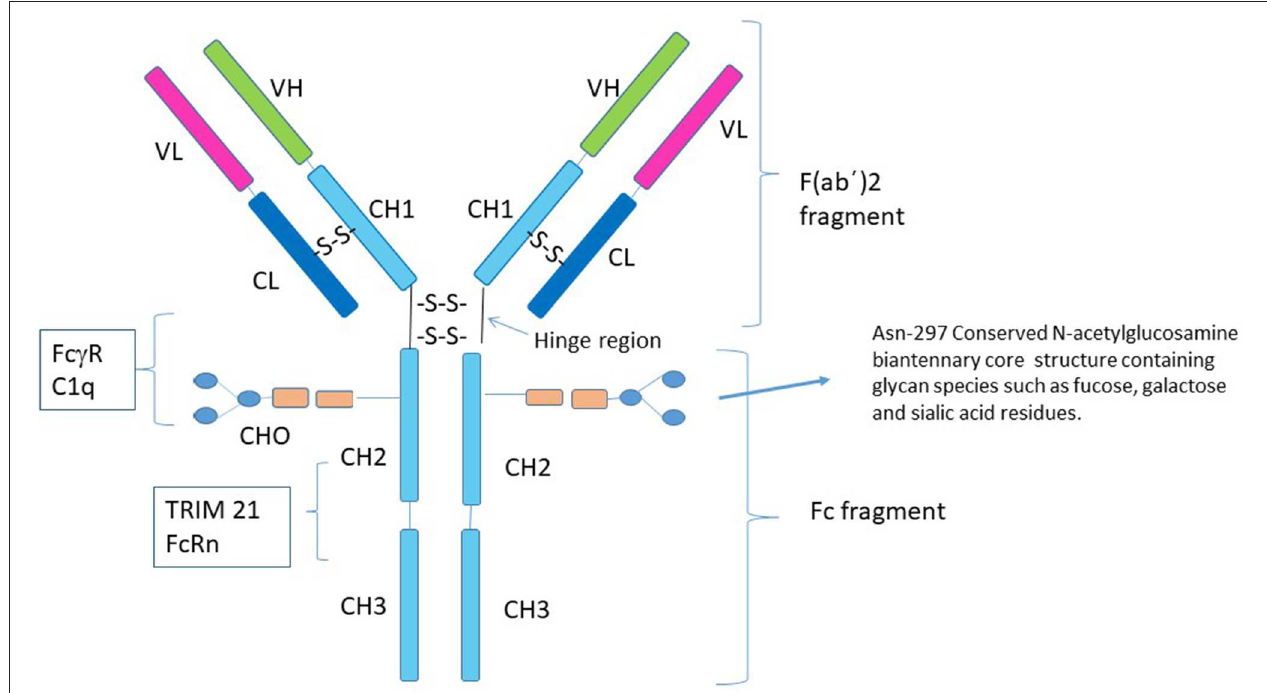
FIGURE 1 | Structure of IgG1. Human IgG consists of four subclasses (IgG1–IgG4) that differ in the number of disulfide bonds in the hinge region, amino acid residues throughout the constant chain as well as their glycosylation patterns. Although the conserved N-linked glycosylation site at Asn-297 is necessary for stabilization